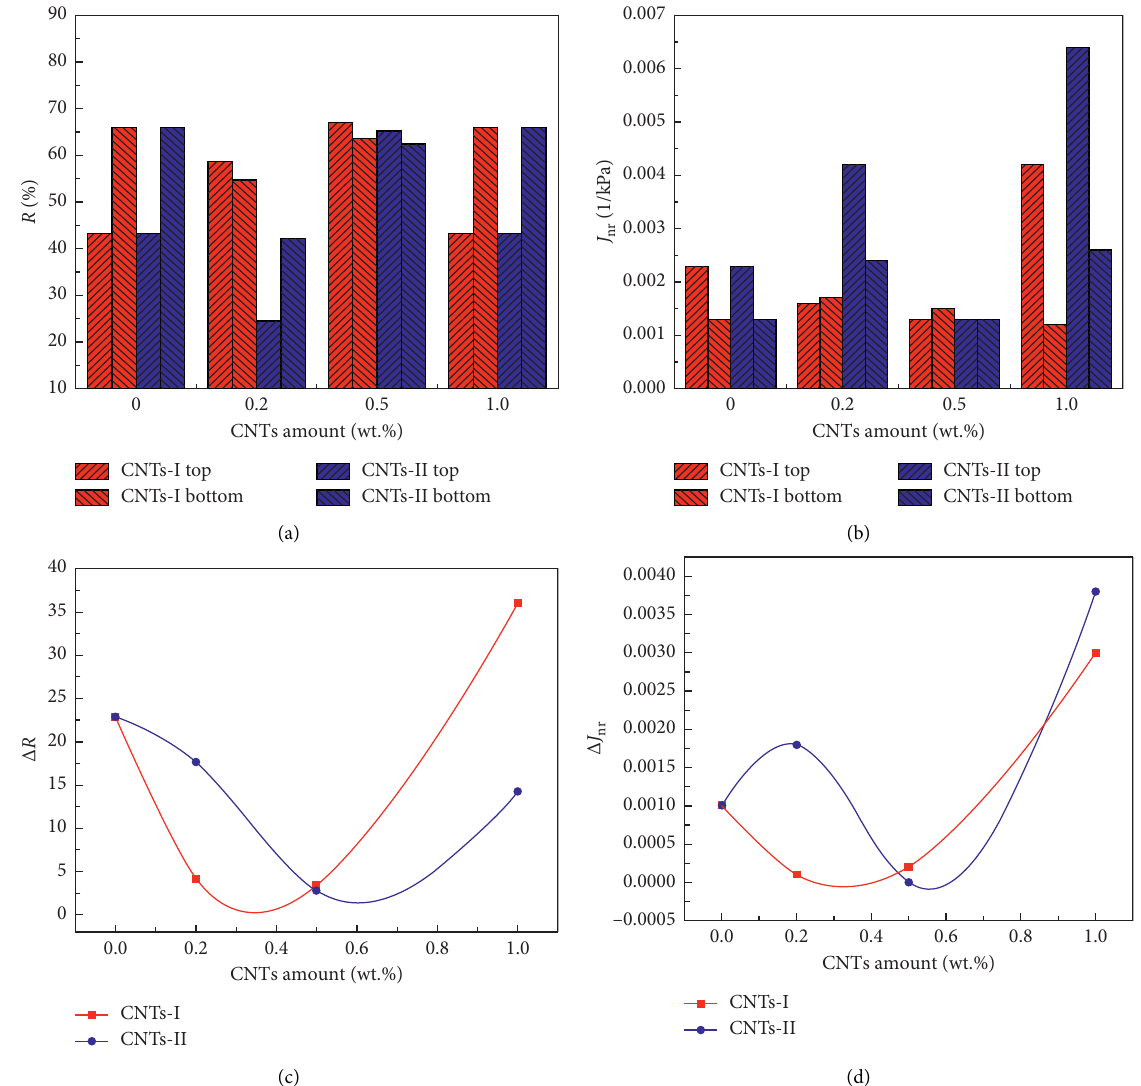
Figure 6: Effect of different amounts of CNTs on R , J nr , △ R , and △ J nr after 2 days of segregation: (a) R , (b) J nr , (c) Δ R , and (d) △ J nr for different amounts of